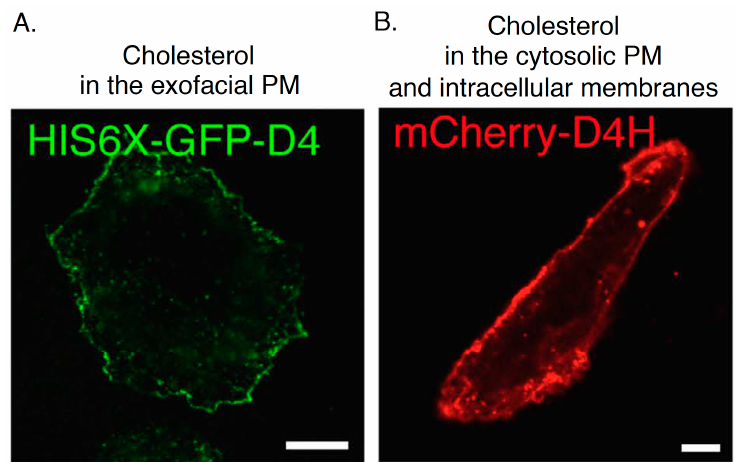
membranes ( B ) are shown. The number is cholesterol concentration (mol %) threshold required for each cholesterol probe-binding.